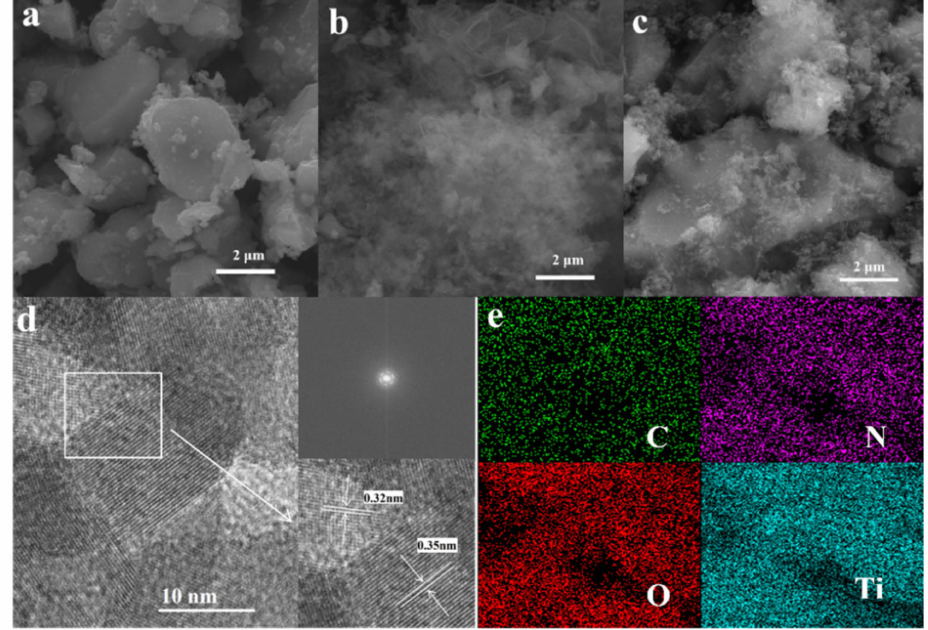
Figure 1. SEM images of ( a ) pure TiO 2 , ( b ) g-C 3 N 4 , and ( c ) TCN-U 20 ; ( d ) TEM image, ( e ) mapping images of TCN-U 20